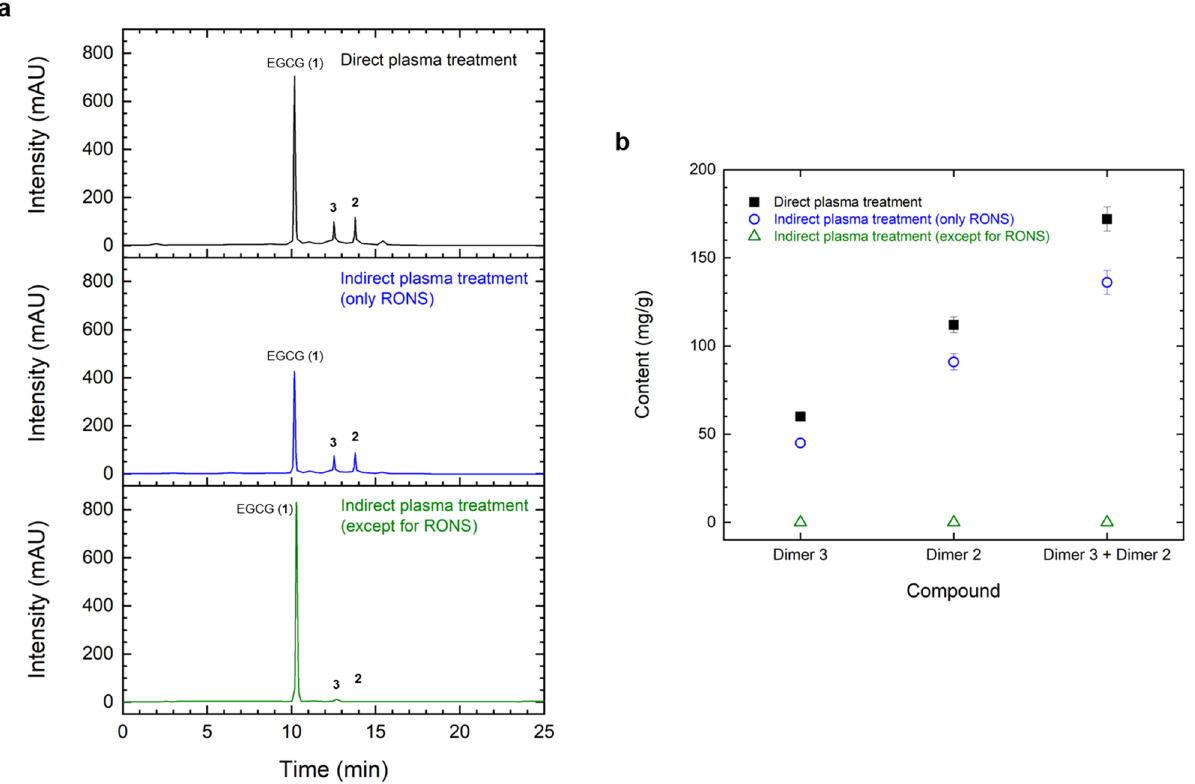
Figure 5. ( a ) HPLC chromatograms of samples according to the plasma treatment conditions, and ( b ) contents of individual components generated by the plasma treatment.